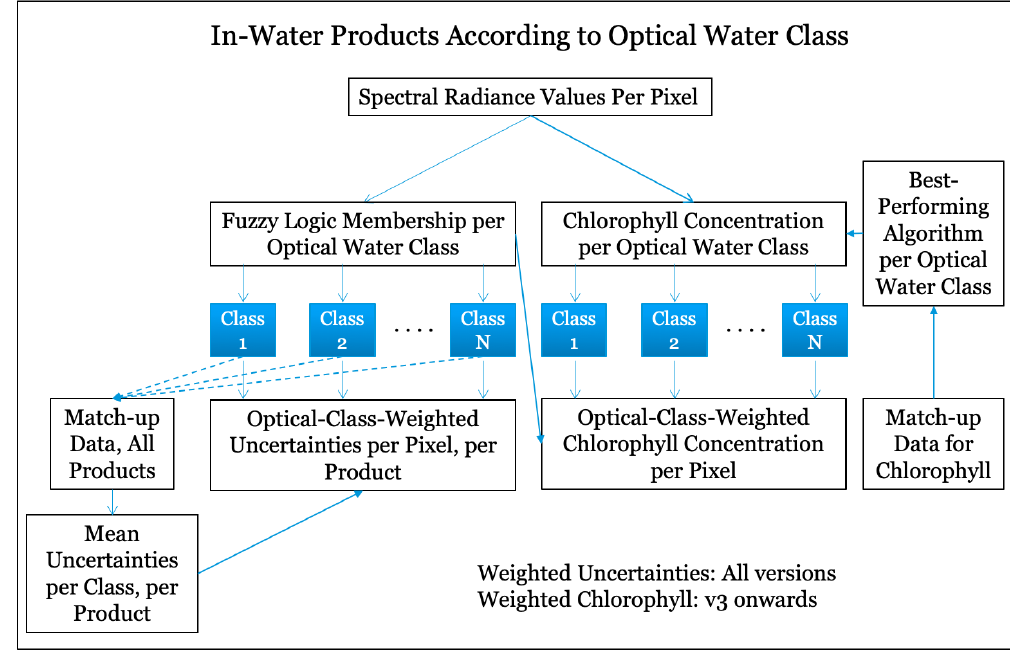
Figure 3. Schematic diagram showing how fuzzy-logic-based optical classification is used to propagate uncertainties in OC-CCI products on a per-pixel basis: From v3 onwards, optical classification